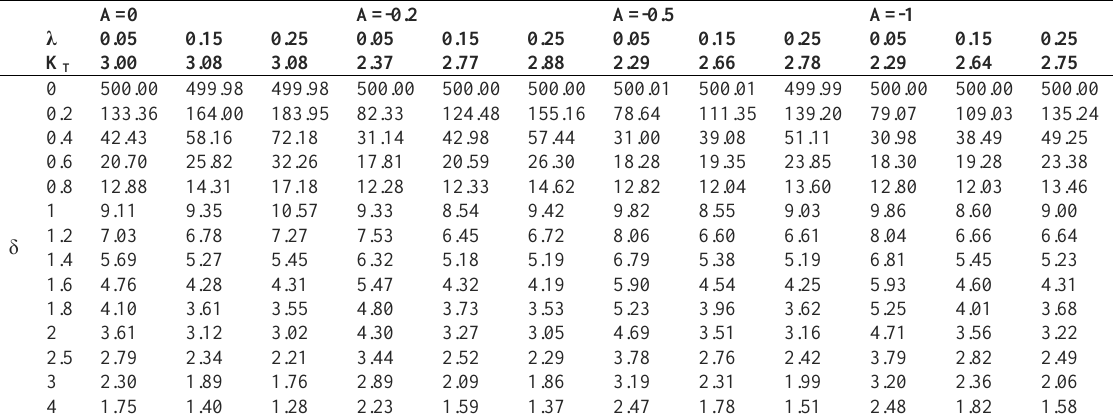
Table 4. ARL results for steady-state time-varying limit one-sided